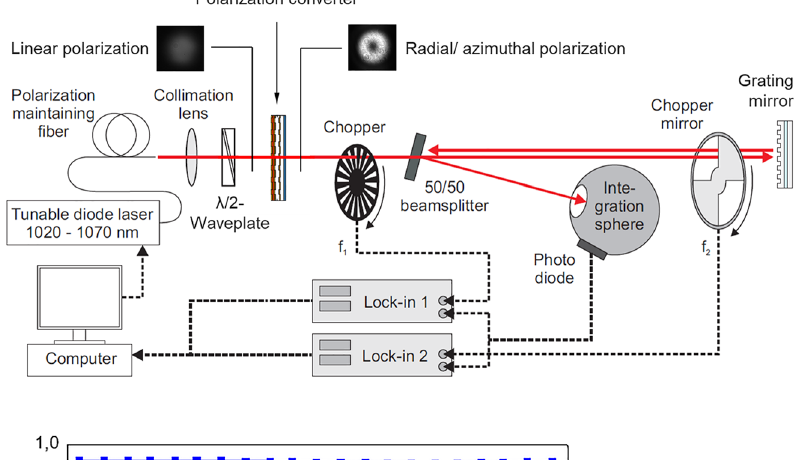
Figure 7: Setup for the spectroscopic measurement according to [58] modi fi ed by using a radially or azimuthally polarized beam to directly measure the re fl ectivities of the axially symmetric GWOCs.